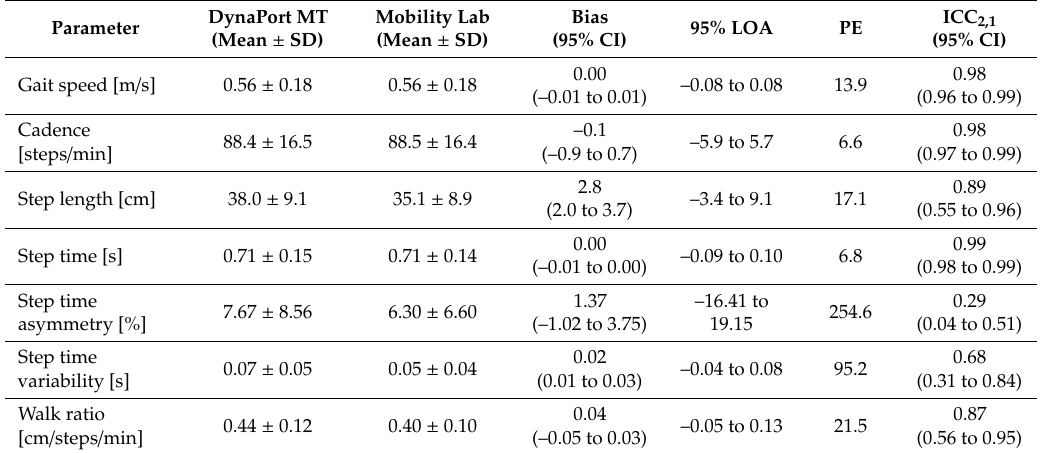
Table 2. Concurrent validity of the DynaPort MT with the Mobility Lab ( n = 58).